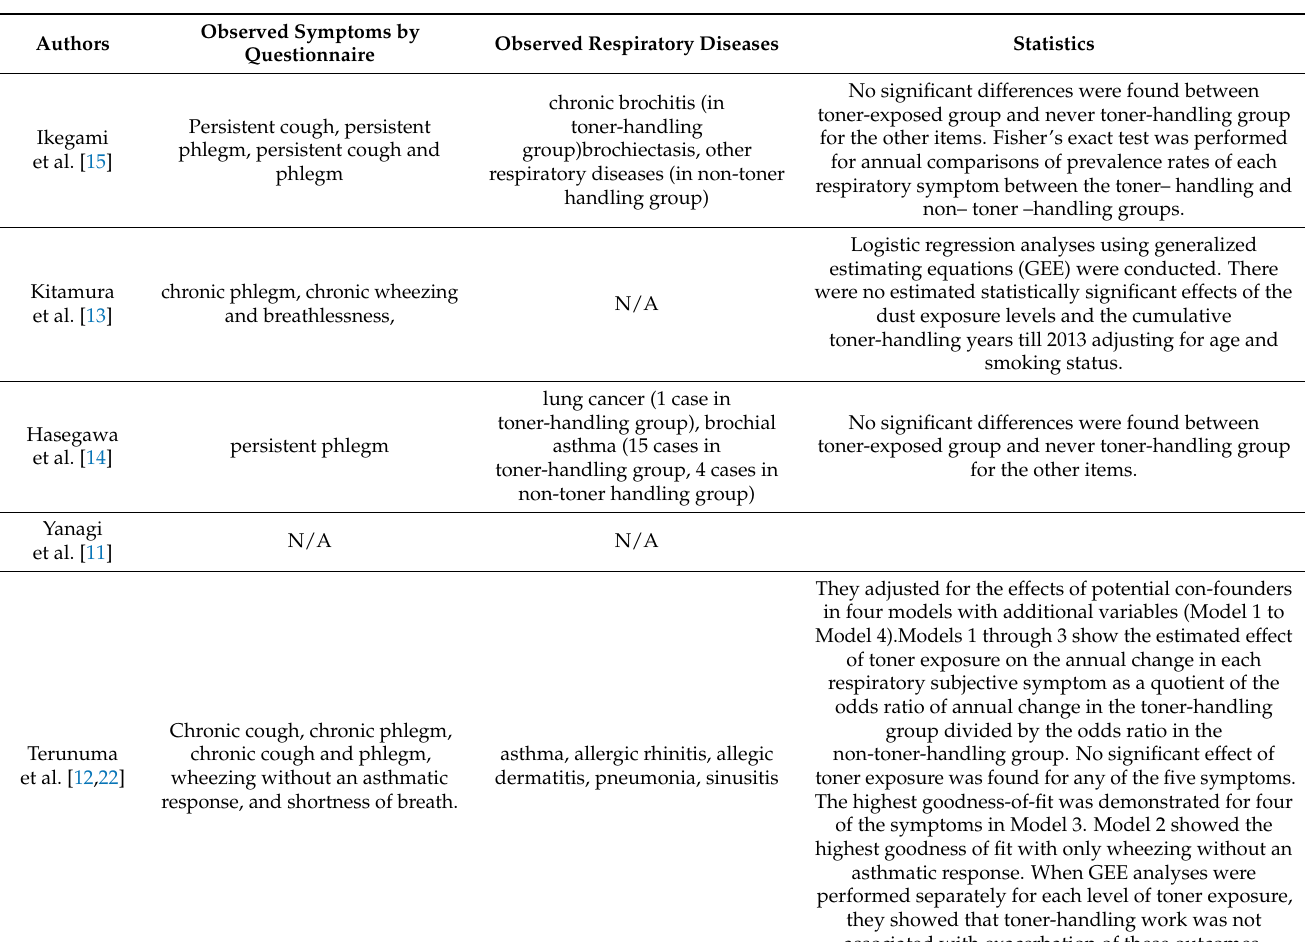
Table 2. Respiratory symptoms, respiratory diseases, and statistical analysis observed in five